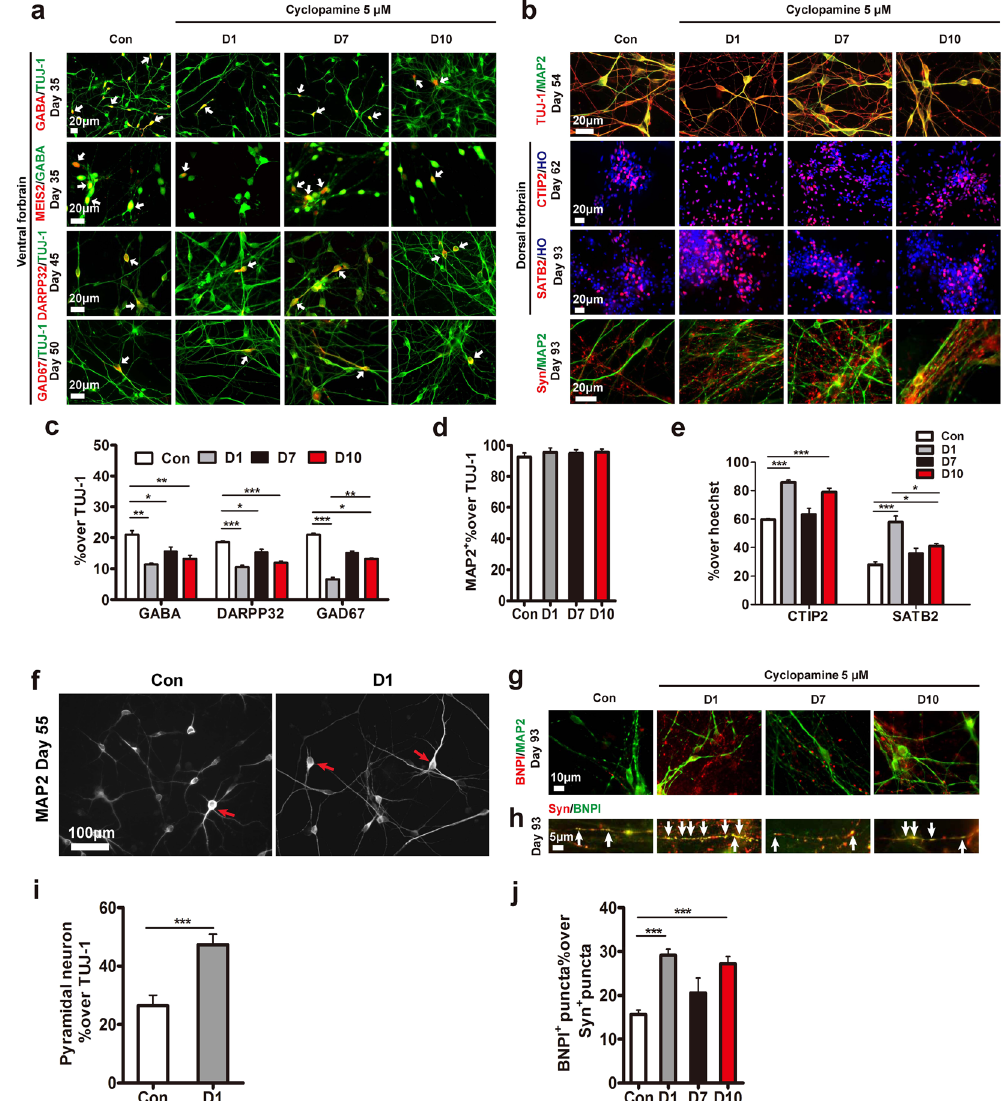
Figure 3. Early application of cyclopamine enriched the generation of glutamatergic neurons. ( a ) Expression of the GABAergic neurons related markers GABA (arrows), DARPP32 (arrows), and GAD67 (arrows) and LGE marker MEIS2 (arrows) from d35. Scale bar, 20 μ m. ( b ) Expression of specific markers of mature neurons (MAP2), cortical neurons (CTIP2 and SATB2) and presynaptic protein synaptophysin from d54. Scale bar, 20 μ m. ( c ) Proportion of GABAergic neurons related markers, including GABA, DARPP32, and GAD67, from d35. * p < 0.05; ** p < 0.01; *** p < 0.001. More than 500 neurons from random fields were manually counted in each condition. The data are presented as the mean ± s.e.m, n ≥ 3 in each condition. ( d ) Proportion of MAP2 + neurons showed no significant differences in all groups. More than 500 neurons from random fields were manually counted in each condition. The data are presented as the mean ± s.e.m, n = 3 in each condition. ( e ) Proportion of CTIP2 + and SATB2 + cortical neurons in total cells. * p < 0.05; *** p < 0.001. More than 1,500 cells from random fields were manually counted in each condition. The data are presented as the mean ± s.e.m, n ≥ 3 in each condition. ( f ) Distinctive pyramidal morphology (arrows) was observed for MAP2 + mature neurons at d55. Scale bar, 100 μ m. ( g ) At d93, mature cortical neurons expressed vesicular glutamate transporters BNPI + puncta. Scale bar,10 μ m. ( h ) At d93, BNPI + puncta (arrows) were clearly observed and co-localized with synaptophysin + puncta. Scale bar, 5 μ m. ( i ) Significantly higher cyclopamine treatment neurons displayed pyramidal morphology. *** p < 0.001. More than 500 neurons from random fields were manually counted in each condition. The data are presented as the mean ± s.e.m, n = 3 in each condition. ( j ) Proportion of BNPI + puncta in synaptophysin + puncta. *** p < 0.001. More than 9,000 synaptophysin + puncta from random fields were manually counted in each condition. The data are presented as the mean ± s.e.m, n = 3 in each